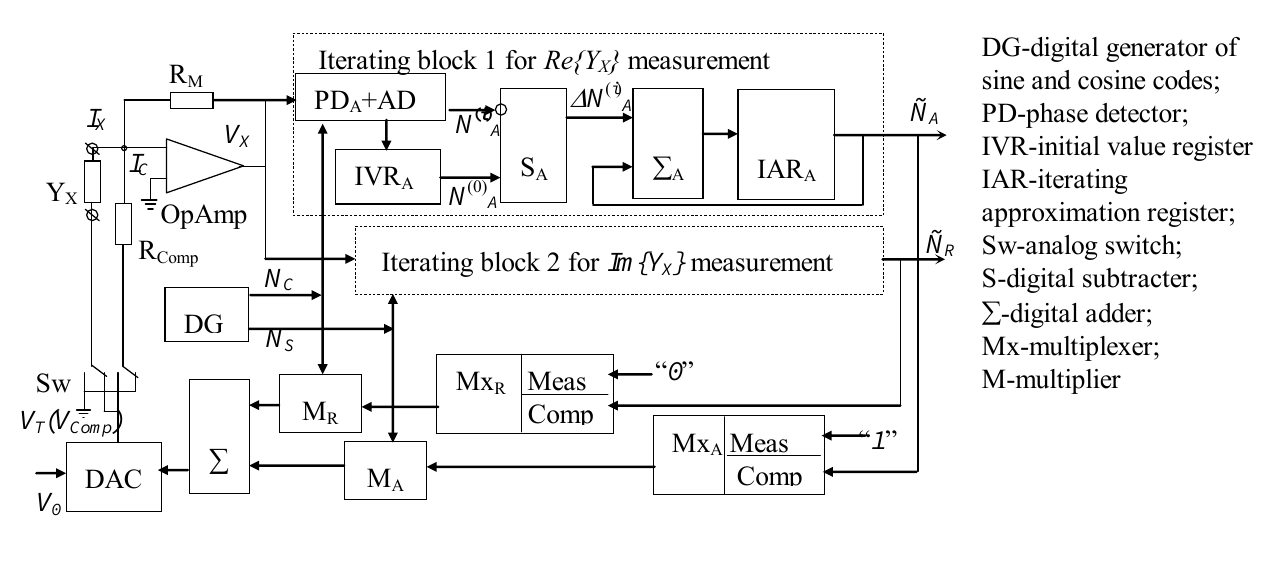
Figure 4. Block diagram of impedance meter with iterating error